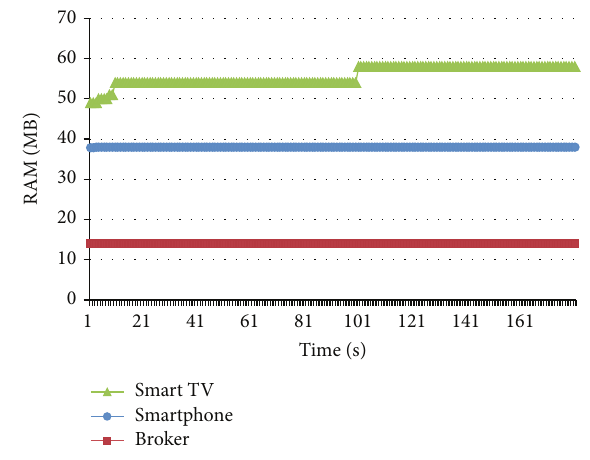
Figure 18: Online test RAM